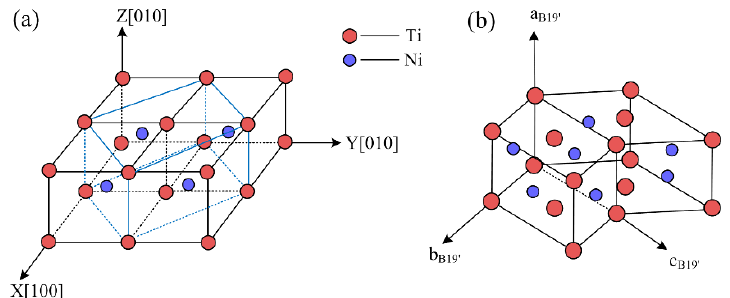
Figure 1. Crystal structures of nickel–titanium shape-memory alloy (NiTi SMA): ( a ) B2 cubic; ( b ) B19′ monoclinic.